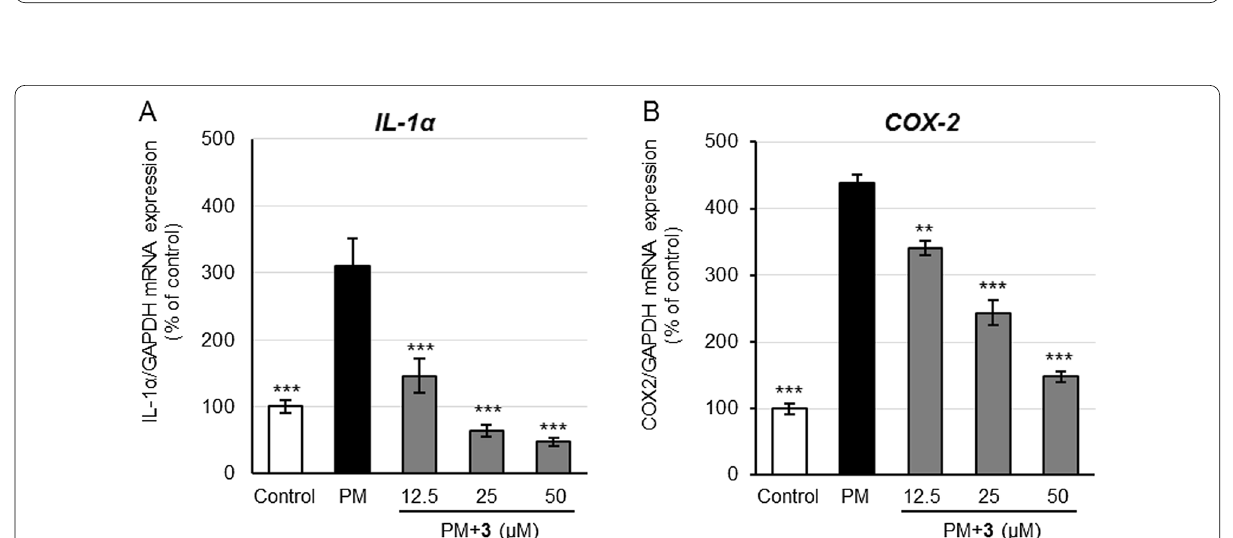
Fig. 5 Inhibitory effects of compound 3 on IL‑1α and COX‑2 mRNA expression in PM‑stressed keratinocytes. NHEKs were treated with compound 3 in the absence or presence of PM for 6 h at 37 °C. Each mRNA expression in the cells was examined by qRT‑PCR. Inhibitory effects of compound 3 against PM‑induced IL‑1α ( A ) and COX‑2 ( B ) mRNA expression in the cells. Bars indicate mean